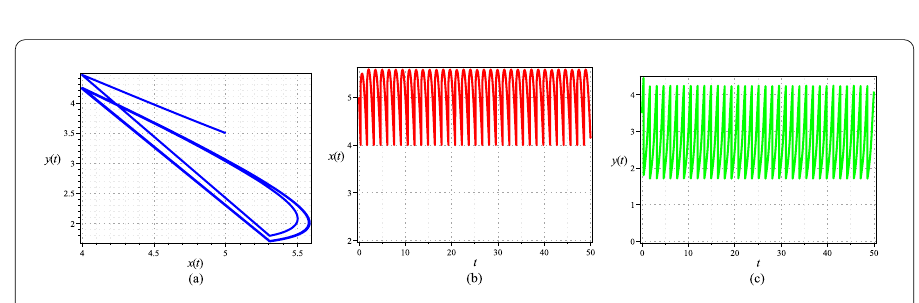
Figure 7 Numerical simulations in the case 0 < h < x E fish density and predator fish density on h = 1.5. (b) Time series of prey fish density. (c) Time series of predator fish density.